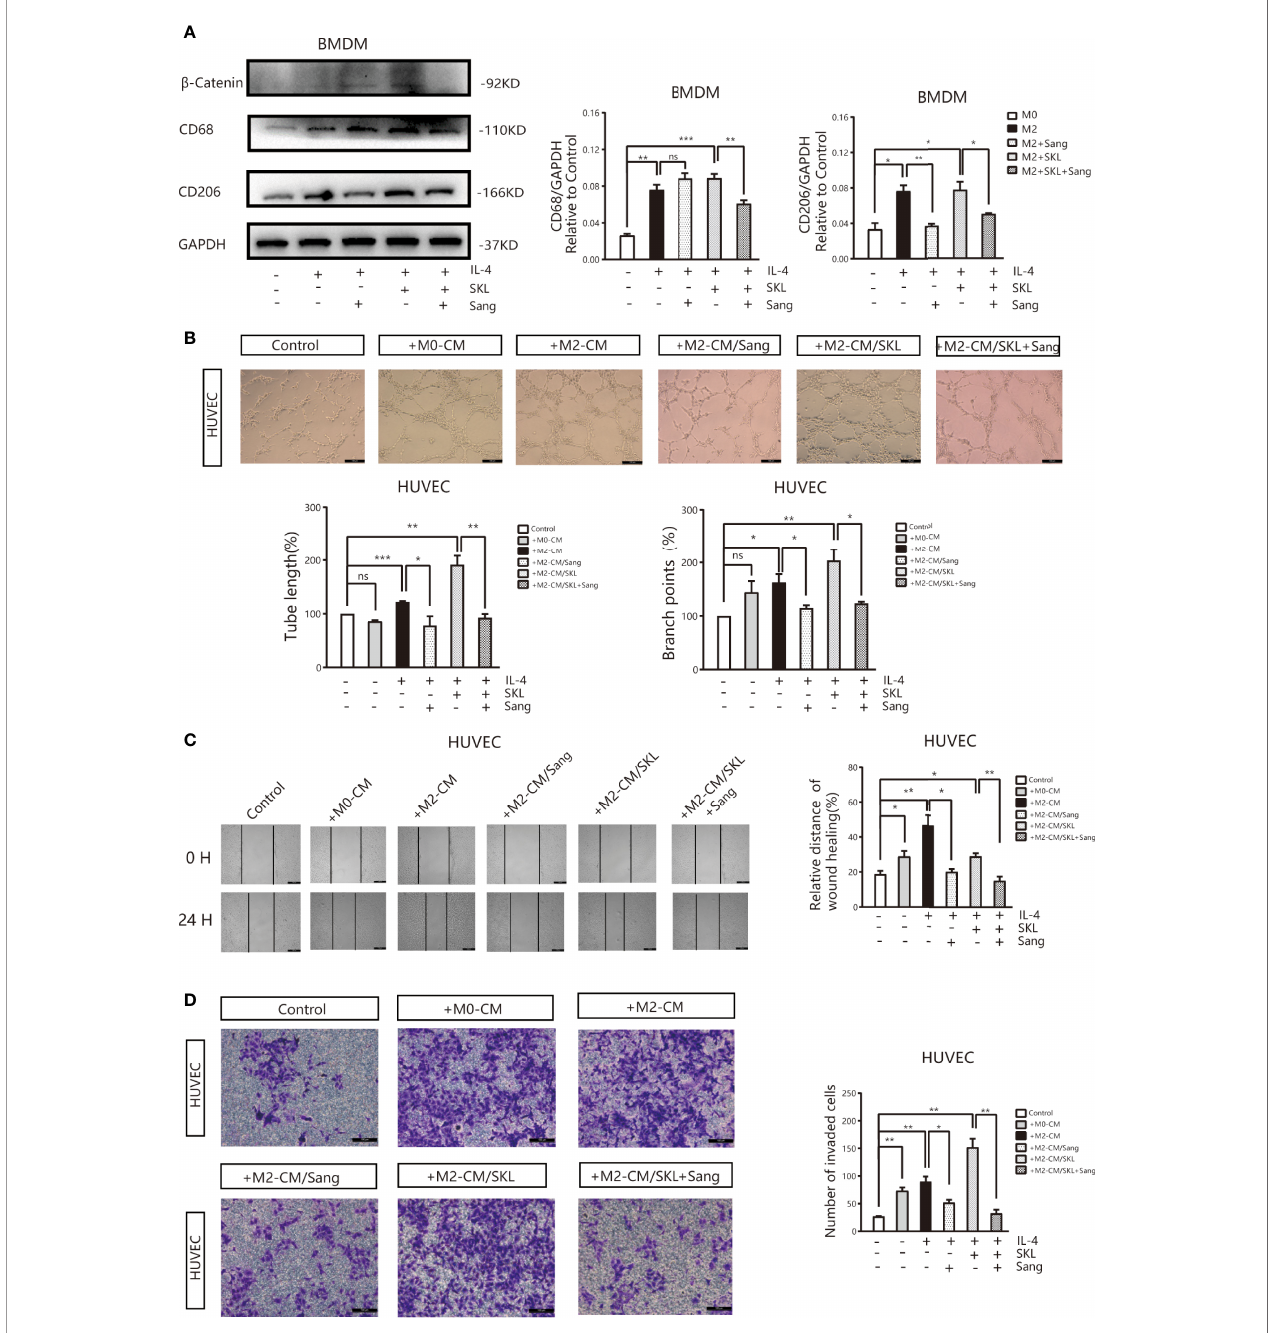
FIGURE 6 | Sang inhibits M2-like polarization of macrophages and M2-mediated angiogenesis by targeting the WNT/ b -Catenin pathway in macrophages. (A) The WNT/ b ‐ Catenin activator SKL2001, alone or in combined with Sang, was utilized to treat BMDMs. Western blotting was performed to detect the protein expression of CD68, CD206, and b ‐ Catenin, and the results indicated that SKL2001 could upregulate b -Catenin and CD206 expression; however, b -Catenin and CD206 were markedly decreased following the SKL2001/Sang combination. (B – D) HUVECs were cocultured with M2 macrophages ’ conditioned medium treated with SKL2001 alone or combined with Sang. (B) Representative images of the HUVEC tube formation assay on Matrigel (magni fi cation 20x) and quanti fi cation of tubes and branch points. (C) Representative images of the wound healing assay of HUVECs at 0 h and 24 h, as well as quantitative analysis of the wound healing area. (D) HUVEC migration and invasion was detected using a Transwell assay. HUVECs were plated in the upper chamber, and the conditioned medium of macrophages after different treatments was collected and placed in the lower chamber. Representative images of HUVEC invasion and quanti fi cation of the number of migrated HUVECs (20X). Each experiment was reproduced three times. *p < 0.05; **p < 0.01; ***p < 0.001; ns, not statistically signi fi cant ( p > 0. 05